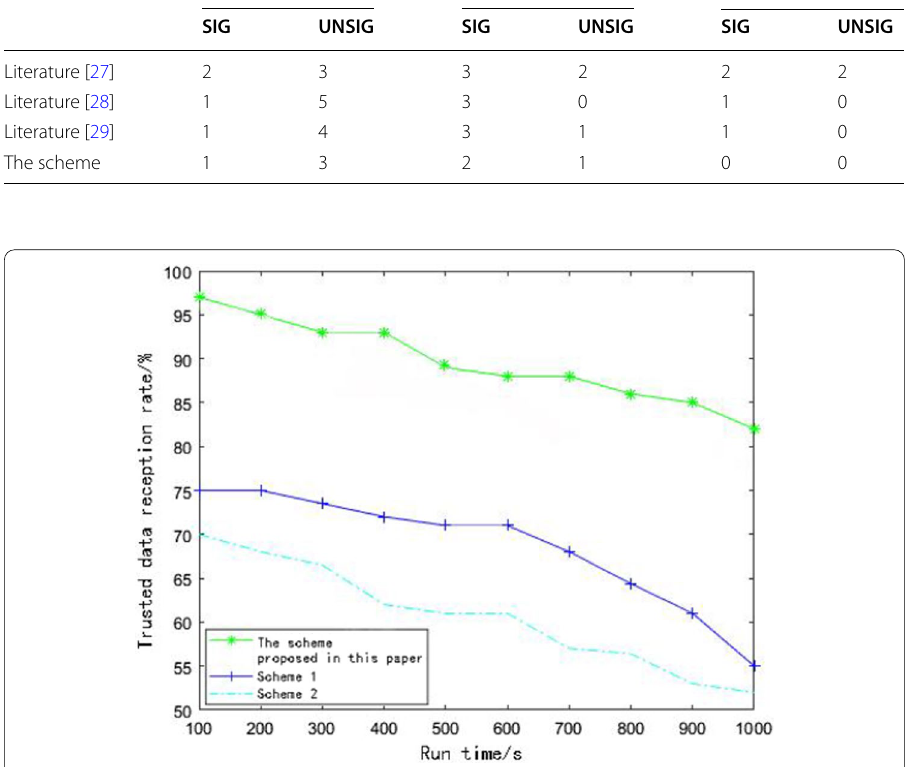
Fig. 3 The trusted data rate of the malicious nodes in